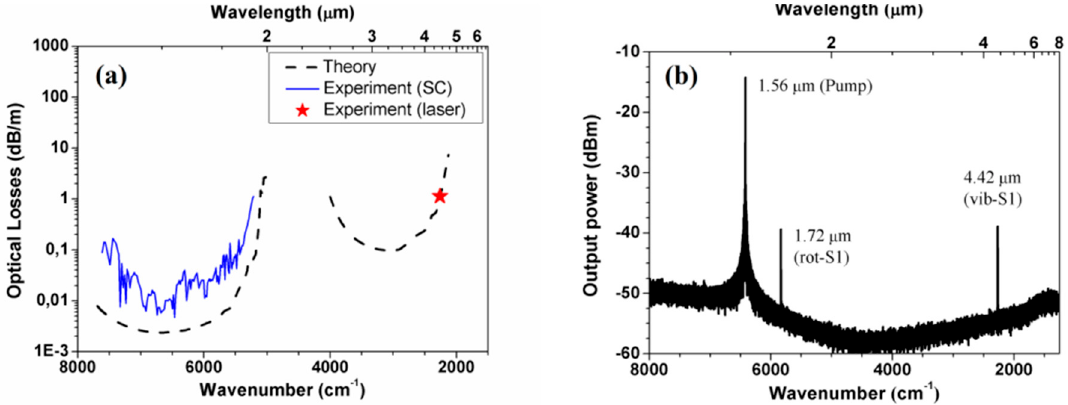
Figure 13. ( a ) Calculated optical loss spectrum of a hollow-core revolver fiber (black dashed lines) [52]. Experimentally measured losses are also shown: near-IR loss spectrum was measured using a supercontinuum source (blue solid line), and optical losses at wavelength of 4.4 μ m (asterisks) was measured using narrow-band laser source [61]; and, ( b ) Output emission spectrum of an RF filled with 1 H 2 at room temperature and a pressure of 30 atm. The launched peak pump power was 18 kW [43,52].